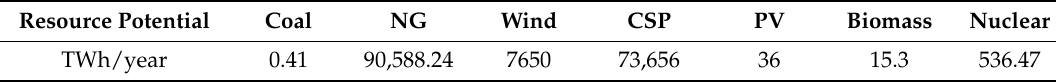
Table 3. Resource potential of technology under